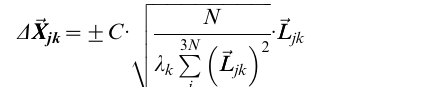
Figure S3 Structural plasticity of gp120 around the F23 and CD4M33-bound states. The atomic fluctuations are calculated using full atomic NMA in a solvent shell (see main text).